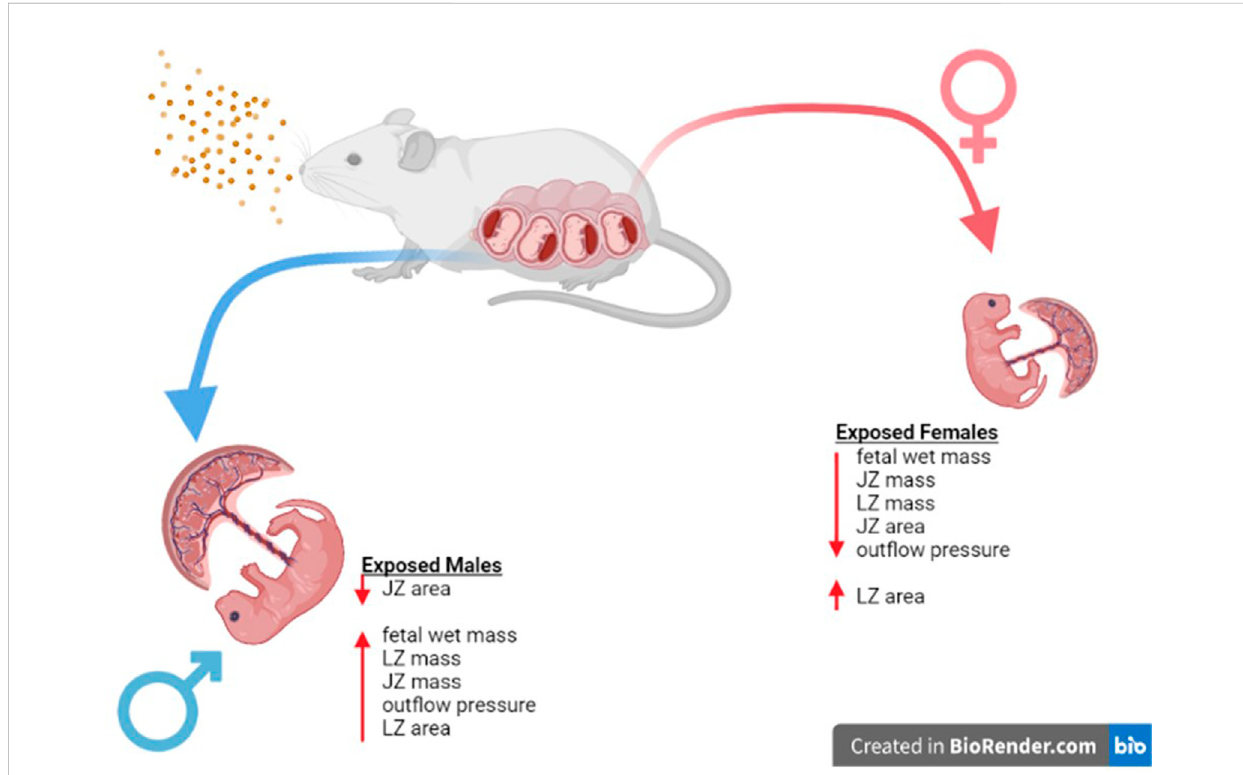
Sex Based Placental Outcomes Summary. Maternal nano-TiO 2 exposure during gestation results in sexually dimorphic outcomes in the placental andfetaltissueatGD20.Femalesundergomoreplacentalchangesincludingdecreasesinmass(JZandLZ)andarea(JZ)whencomparedtomales.These resulting changes may be responsible for the decreased fetal mass seen in females compared to their male counterparts at GD 20, and these changes have been shown to result in health de fi cits for the females into adulthood (Bowdridge et al.,